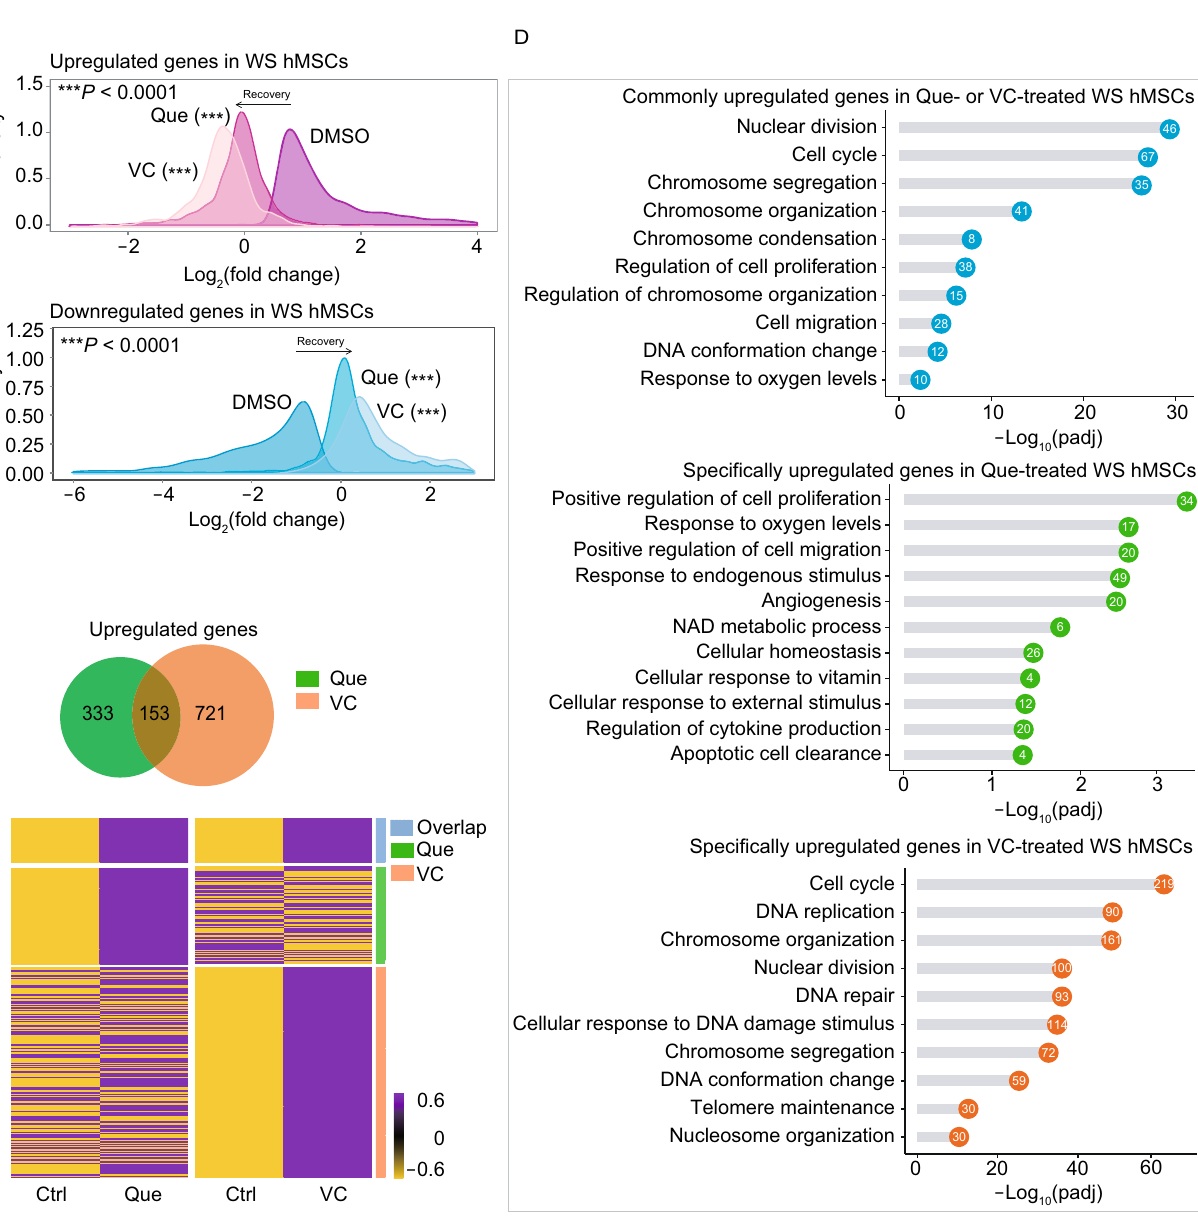
Figure 8. Comparative analysis of the RNA-seq data for Que- and VC-treated WS hMSCs. (A) Density plot showing upregulated genes in WS hMSCs restored upon Que or VC treatment. (B) Density plot showing downregulated genes in WS hMSCs restored upon Que or VC treatment. (C) Venn diagram and heatmap comparing upregulated genes in Que- or VC-treated WS hMSCs. (D) GO enrichment analysis for commonly upregulated genes in Que- or VC-treated WS hMSCs (top), genes only upregulated in Que-treated WS hMSCs (middle), and genes only upregulated in VC-treated WS hMSCs (bottom). The number of enriched genes in each GO term is shown in the